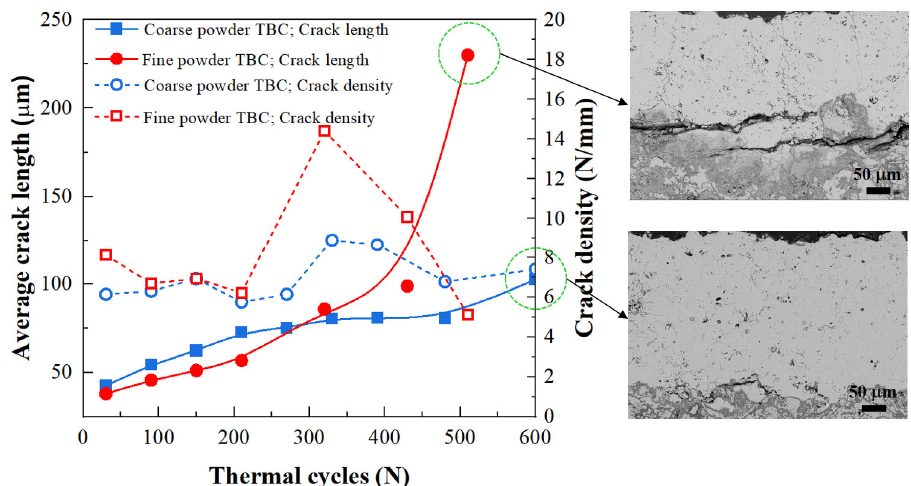
Figure 8. Evolution of crack length and density in the two kinds of coatings during thermal cycling test and typical crack morphology in coatings after thermal cycling.